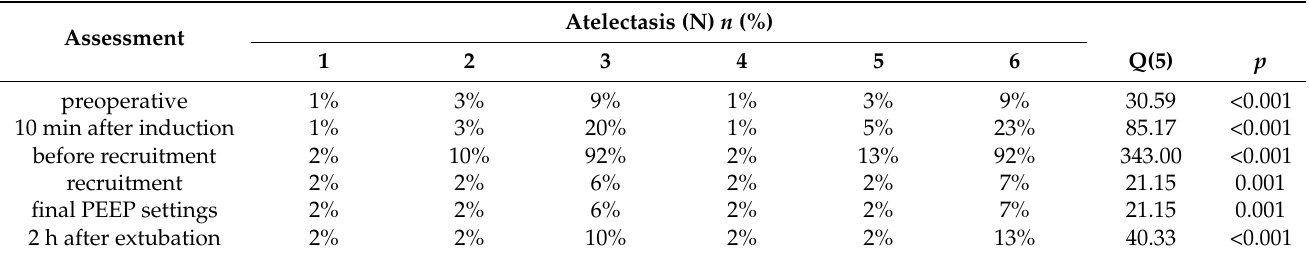
Table 2. Frequency of atelectasis depending on